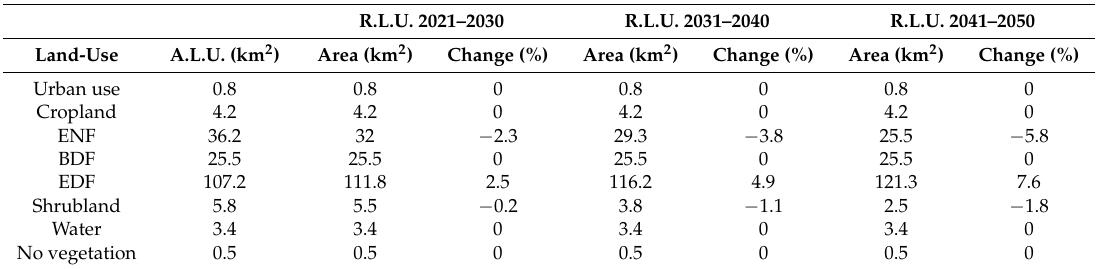
Table 2. The area of each scenario (actual land-use—A.L.U. and revegetation land-use—R.L.U.) and variation (%) with respect to